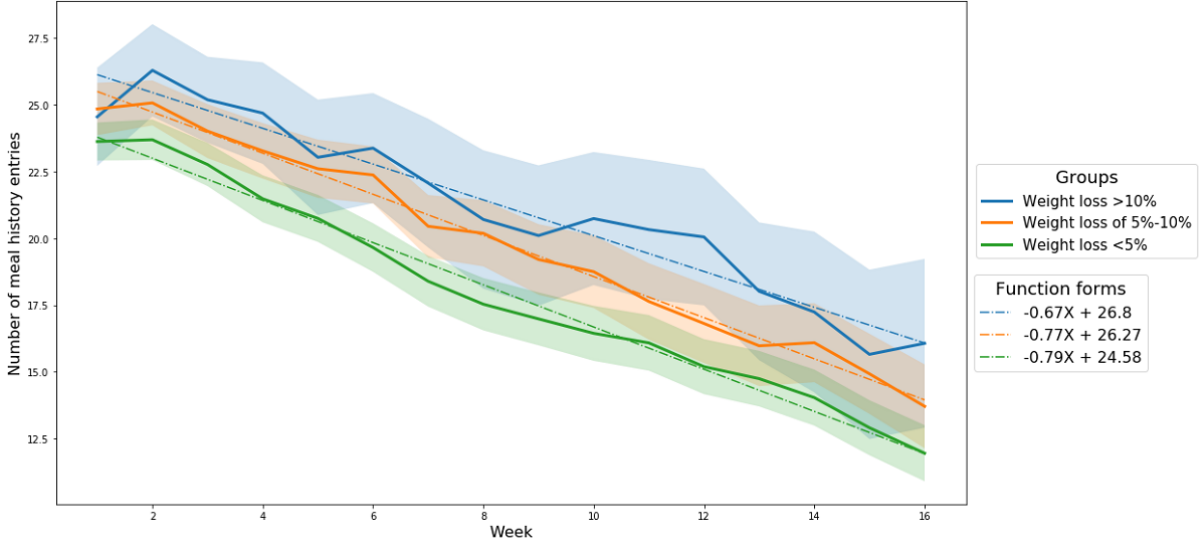
Figure 5. Number of meal history entries on a weekly basis over 16 weeks; the colored bands show the 95%